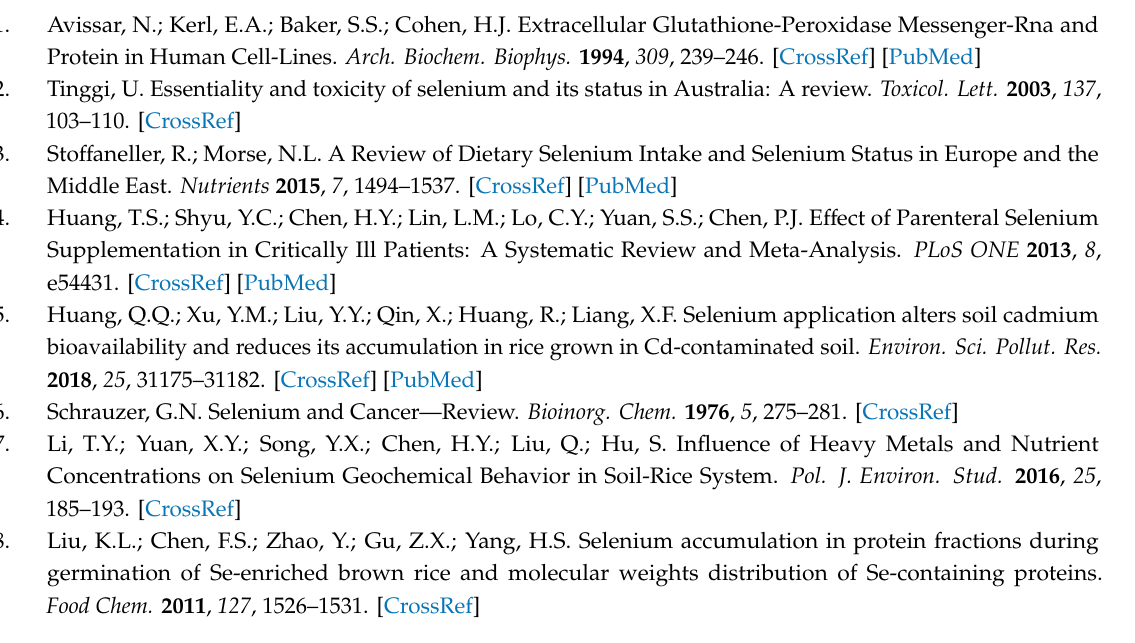
Figure S1: Map showing the geographical location and population of ten sampling areas in China where common rice and selenium-rich rice were collected. (Population data came from China’s sixth census), Table S1: Working parameters of inductively coupled plasma mass spectrometry (ICP-MS), Table S2: The daily rice intake of residents of di ff erent gender and age population groups in China, Table S3: Distribution of organic selenium and inorganic selenium in selenium-rich rice ( µ g / 100 g, wet weight). All data and material generated or used during the study are fully available without restriction. Supplementary data associated with this article can be found in the online